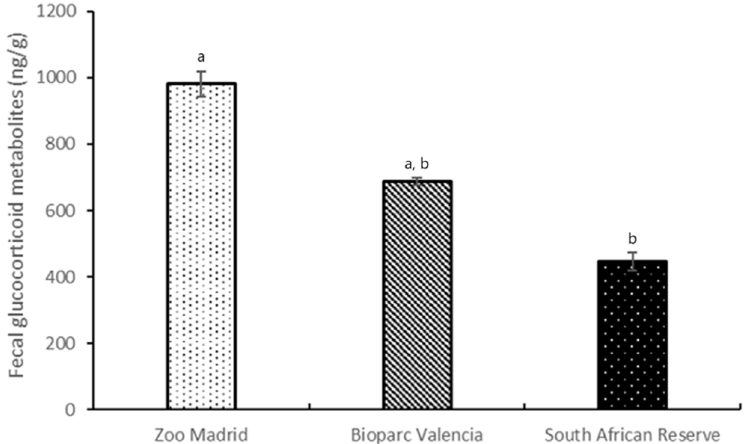
Figure 5. Fecal glucocorticoid metabolite concentrations (fGCM) ± standard error of the mean (S.E.M.) among the three groups studied. Values with distinct superscript letters (a, b) denoting statistical differences ( p value < 0.10) among groups using the Kruskal–Wallis and Bonferroni tests. Variables Sex and